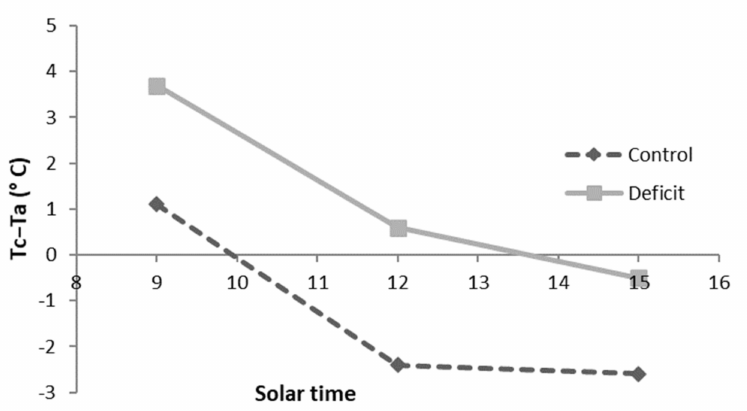
Figure 5. Differences between canopy and air temperature at three times of the day in control (100% ETc) and deficit (0% ETc)